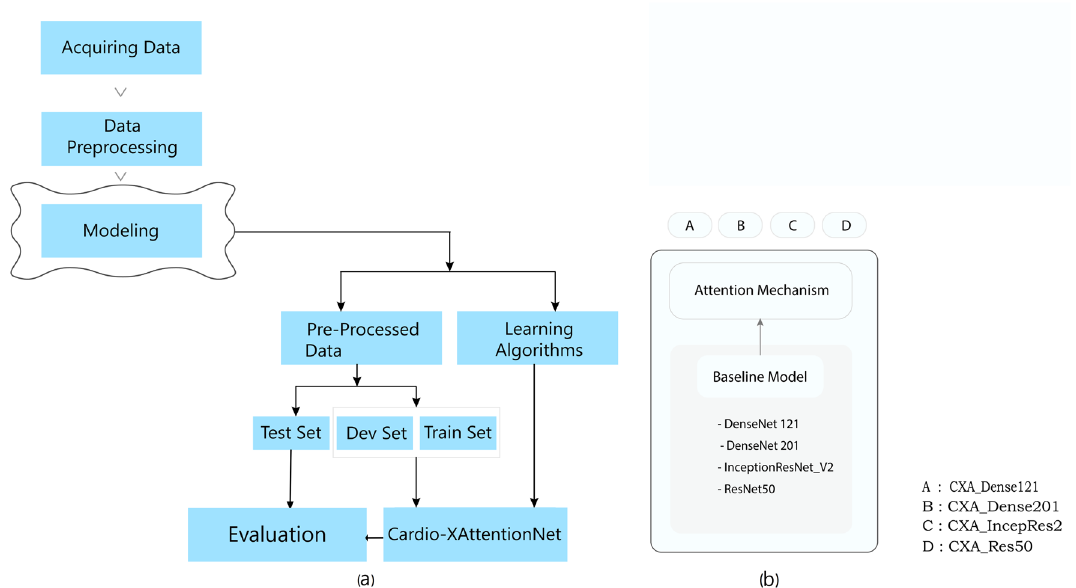
Figure 2. ( a ) Model’s Framework: pre-processing the acquired data to make the training part (train set and dev set) for end-to-end training and learning algorithms to build the models; test set is used to final assessment of the models. ( b ) Architectural design of the learning algorithms. A: CXA_Dense121, B: CXA_Dense201, C: CXA_IncepRes2 and D: CXA_Res50 are built by integrating AMM with the baseline models of DenseNet121, DenseNet201, Inception_ResNet_V2 and ResNet50